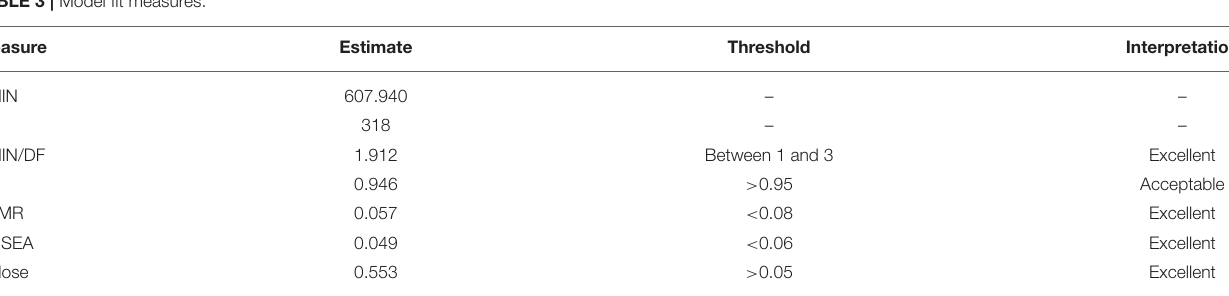
TABLE 3 | Model fit measures.